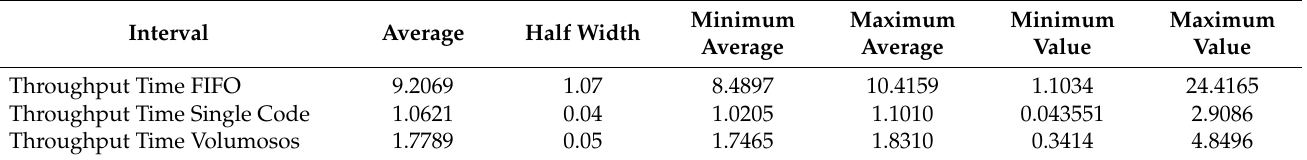
Table 8. Throughput